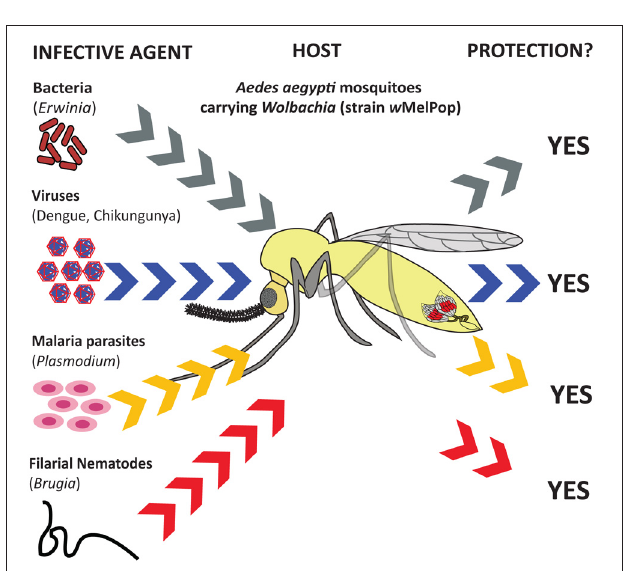
FIGURE 2 | Influence of Wolbachia endosymbionts on inhibition/reduction in transmission capacity as well as protection of mosquitoes against infection. Aedes aegypti mosquitoes transinfected with the Wolbachia strain w MelPop are protected from infection by pathogenic bacteria ( Erwinia carotovora ) (Kambris et al., 2009), viruses (dengue and Chikungunya) (Moreira et al., 2009), malaria parasites ( Plasmodium gallinaceum ) (Moreira et al., 2009), and parasitic filarial nematodes ( Brugia pahangi ) (Kambris et al.,